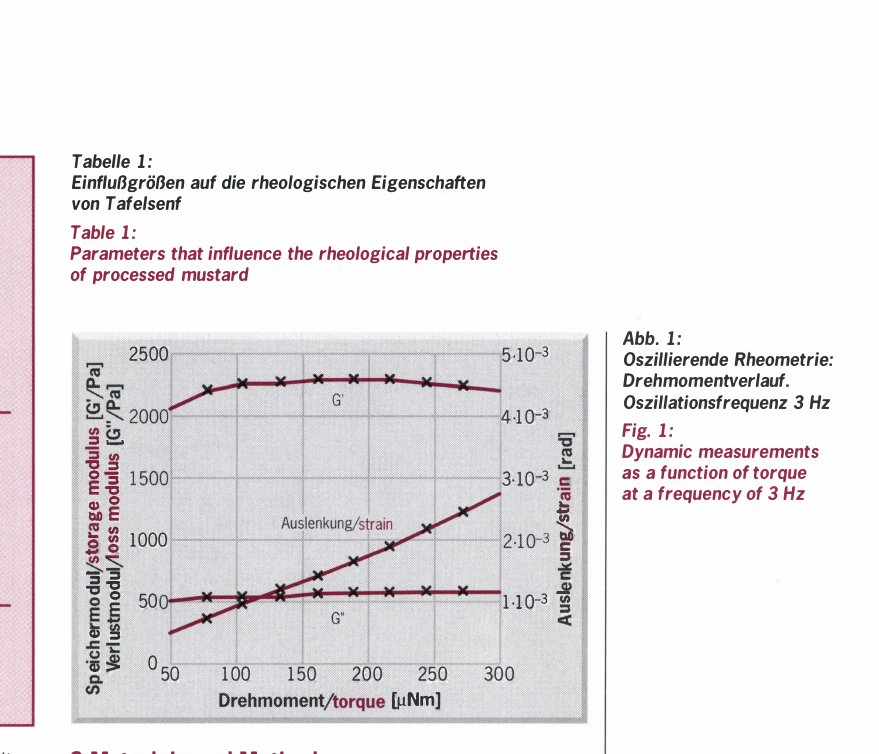
Table 1: Parameters that influence the rheological properties of processed mustard